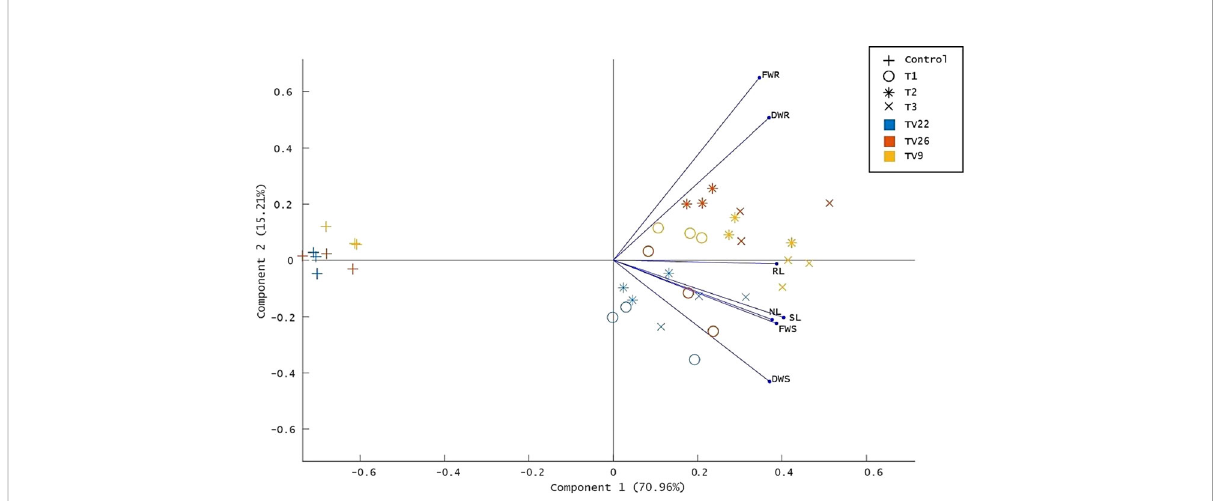
FIGURE 8 Principle component analysis biplot based on correlation matrices of the PGP dataset of growth parameters and treatment groups. Tea clones - TV9, TV22, and TV26. C- Control, Untreated plant; T1-Treatment 1, KA12; T2- Treatment 2, MA34; T3- Treatment 3, Consortia of KA12 and MA34. PCA resulted in two major principal components (PC) with a variance of 70.96% (PC1) and 15.21% (PC2) on reduction of the dimension of the various PGP parameters. FWR, fresh weight root; DWR, dry weight root; RL, root length; SL, shoot length; NL, number of leaves, FWS, fresh weight shoot; DWS, dry weight